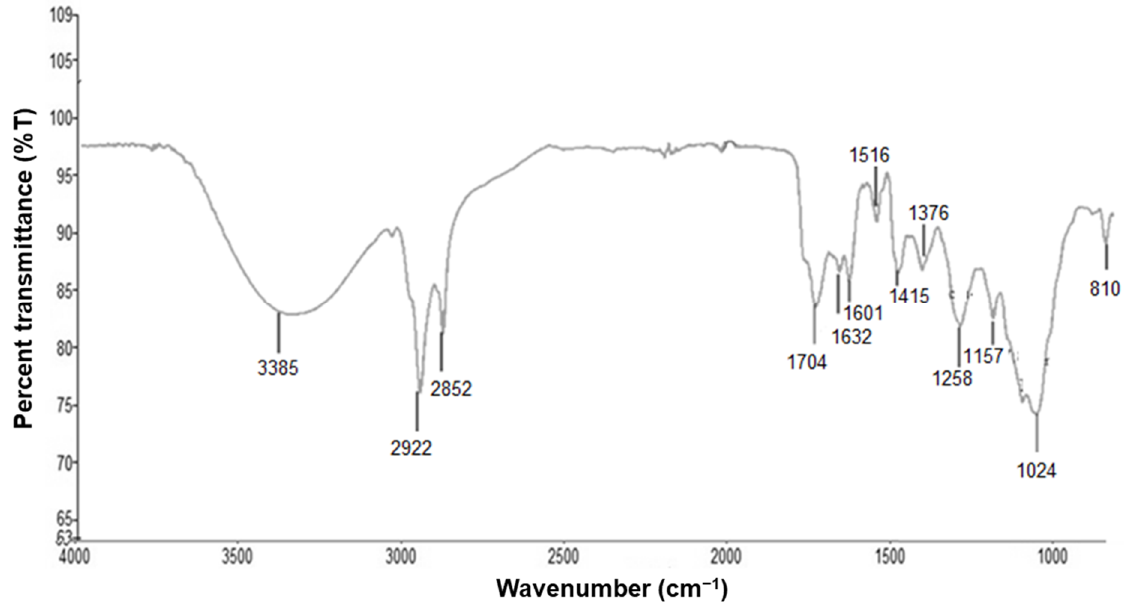
Figure 7. FTIR spectra of biosynthesized CuNPs of mace showing probable functional groups in the synthesized